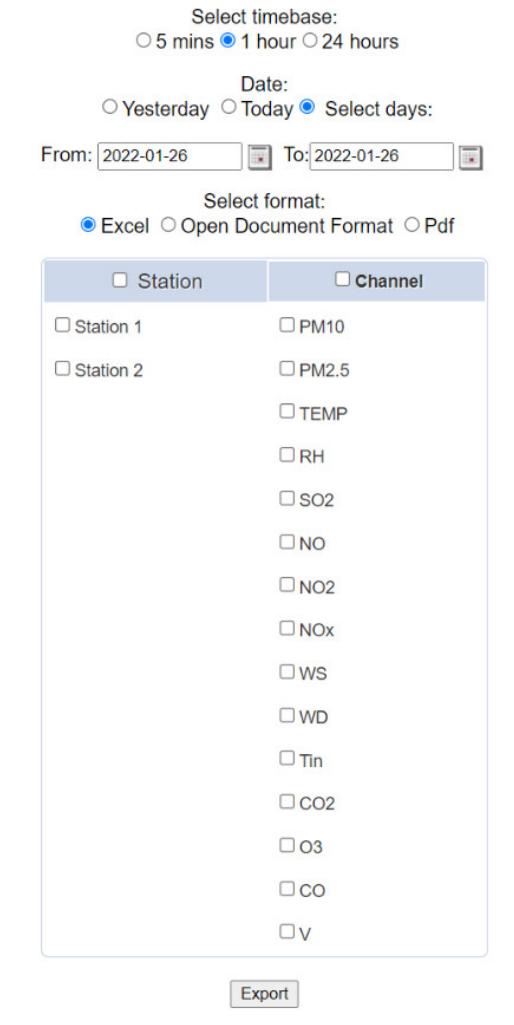
Figure 8. Data export form.